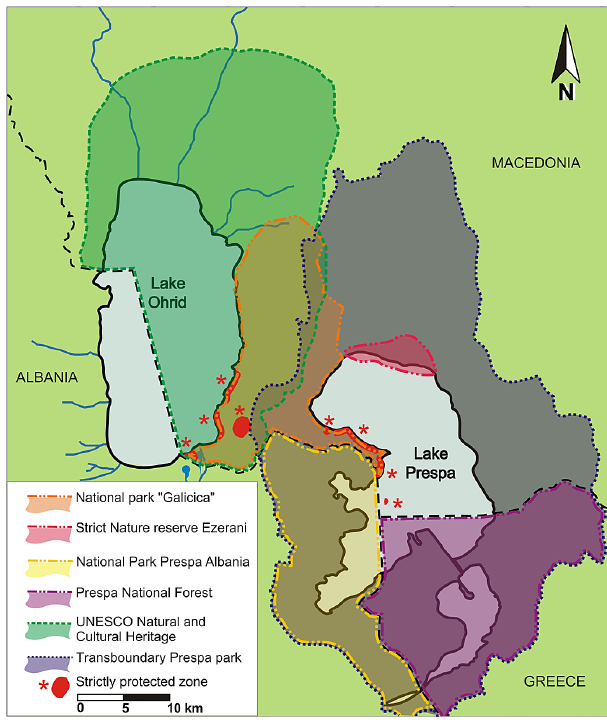
Fig. 3. Conservation areas in the transboundary Ohrid Prespa lakes region. Within Galicica National Park, strictly protected zones are shown only (Veli Dab area and Sv. Naum at Lake Ohrid). Note that the Pelister National Park (Macedonia) has been